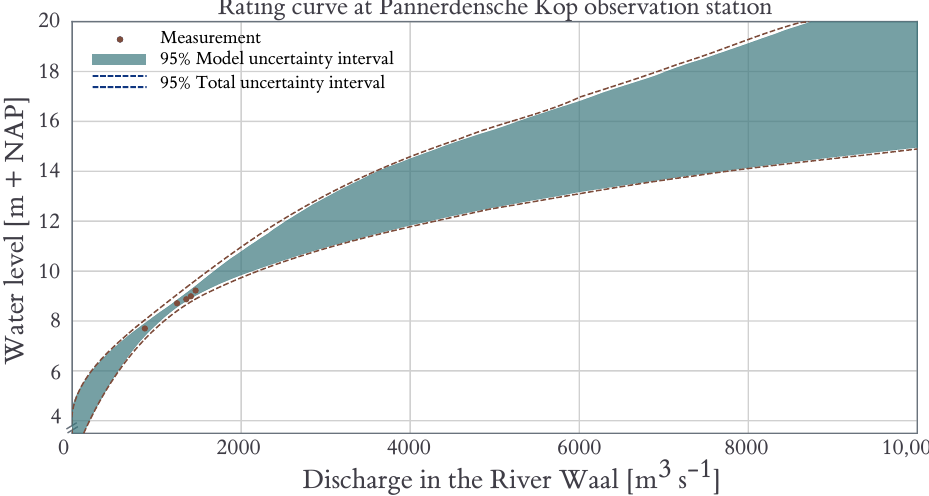
Figure 7. Years with fewer measurements have comparatively large uncertainty intervals, especially in extrapolation. Shown here is the rating curve for 1997 (five